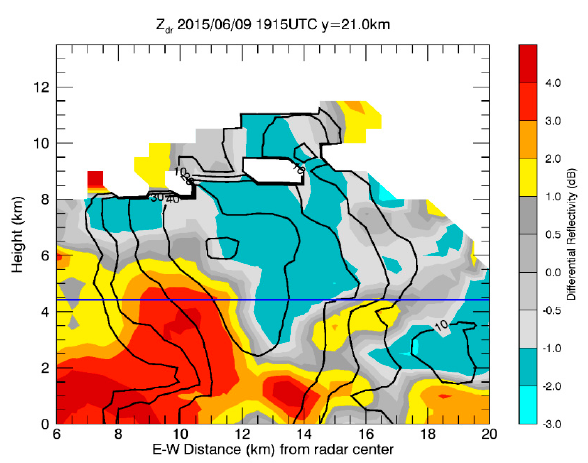
Figure 3. Vertical cross-section of Z dr (shaded) and Z h (black contour every 10 dBZ, from 10 dBZ to 50 dBZ) at the location shown as black line in Figure 2. The horizontal blue line indicates the 0 °C isotherm height.